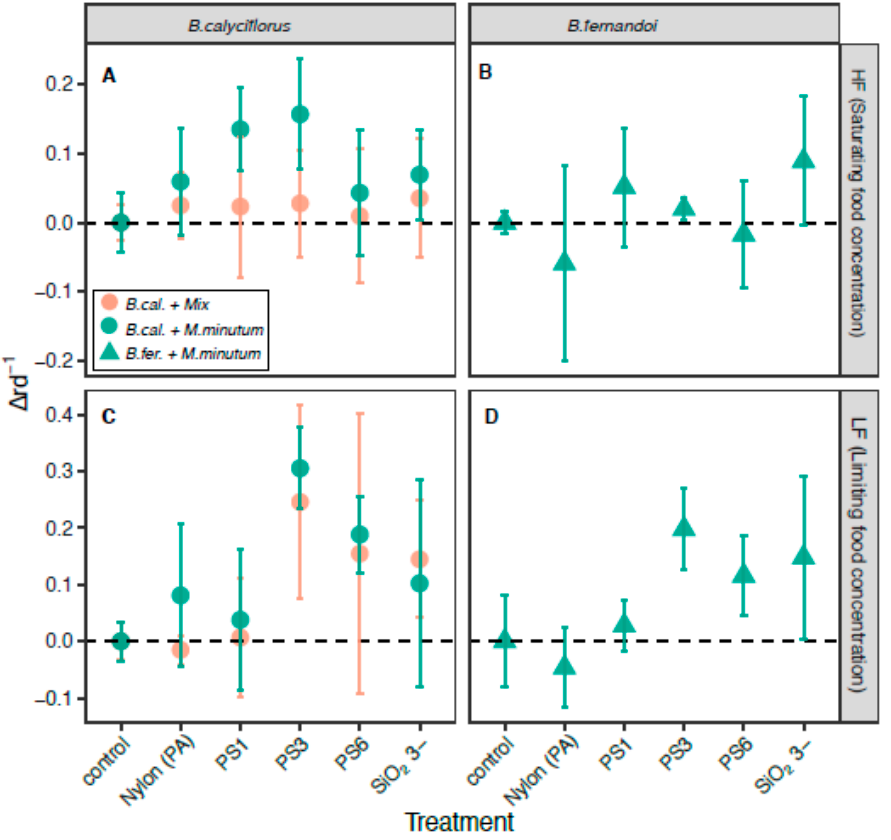
Figure 1. Intensity of food reduction ( ∆ r ± 95% confidence interval (CI)) of the rotifer B. calyciflorus and B. fernandoi at high and low food concentrations; ( A – C ) the red circles refer to the experiment with B. calyciflorus and the mixed algal diet ( M. minutum and Cryptomonas sp.), and the green circles refers to the experiment with B. calyciflorus and one algal species ( M. minutum ); ( B – D ) the green triangle refers to B. fernandoi . Table 1. Results of three-way ANOVAs using square-root transformed data on the egg ratio and Yeo–Johnson transformed data on survival (lambda = 4.99) for the two rotifer species ( Brachionus calyciflorus and Brachionus fernandoi ) and the two algal diets ( Monoraphidium minutum ; Monoraphidium minutum + Cryptomonas sp.). The two species were provided with two quantities (0.5 and 2.0 mg C L − 1 ) of Monoraphidium minutum . B. calyciflorus was provided with the same food quantities of a mixture of Monoraphidium minutum and Cryptomonas sp. as food.